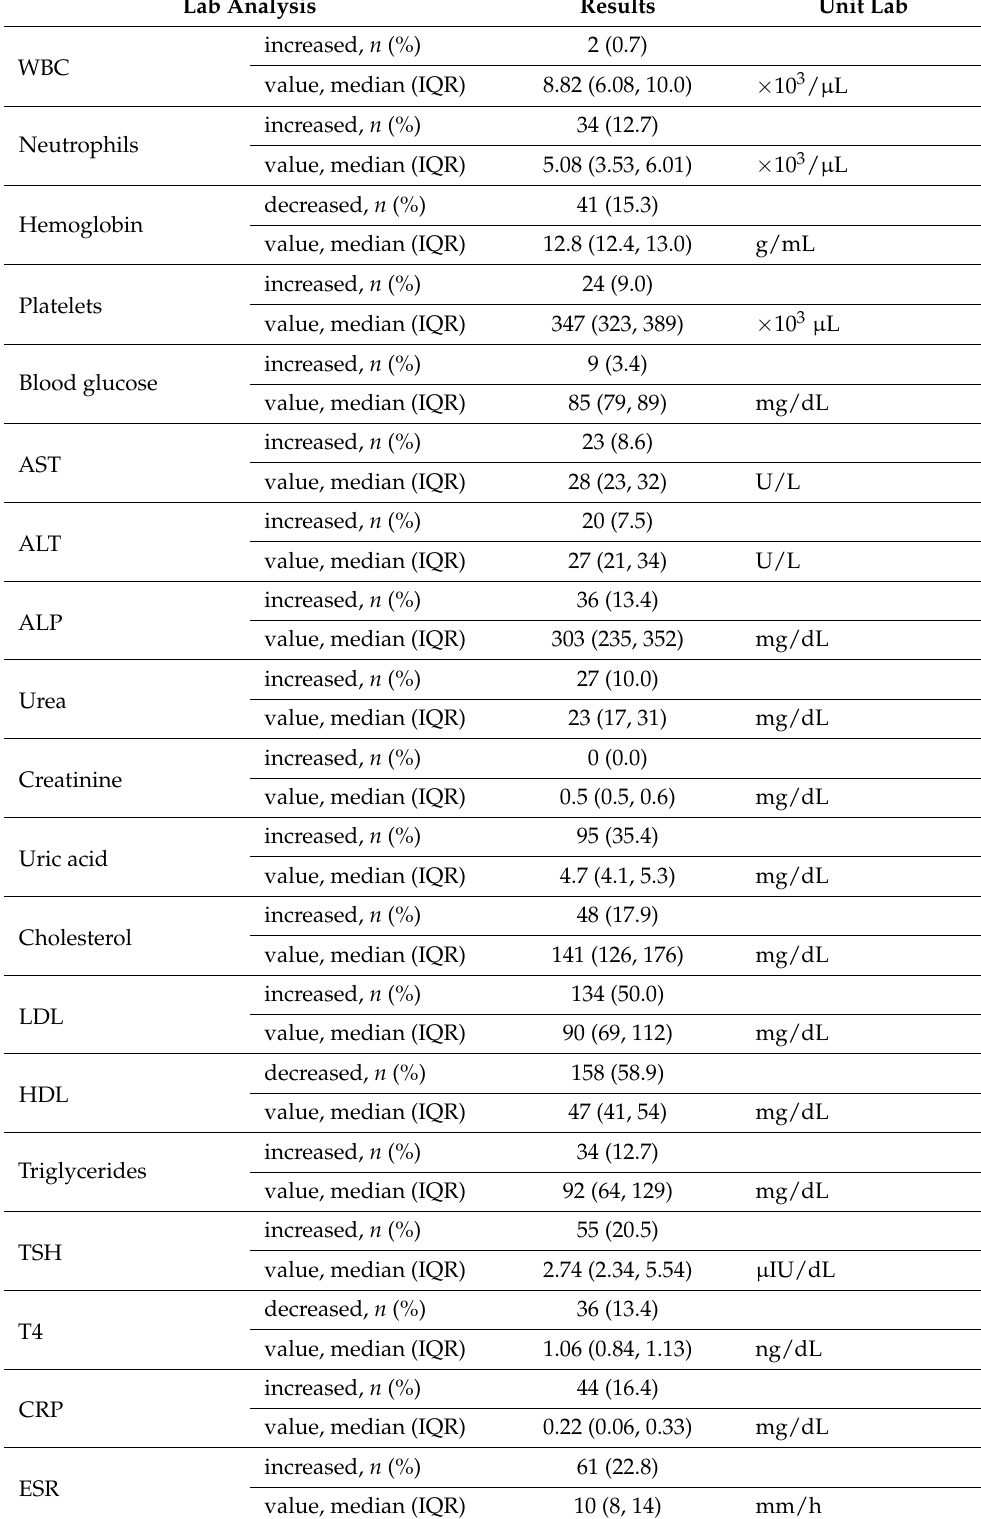
Table 1. Laboratory findings in the study